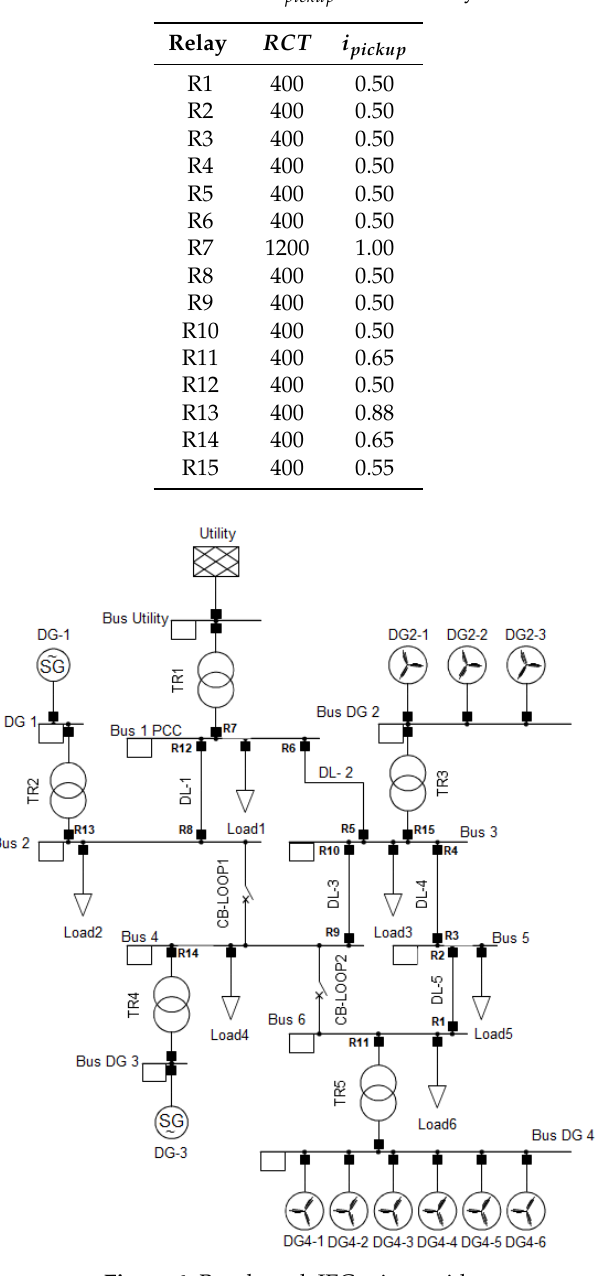
Figure 6. Benchmark IEC